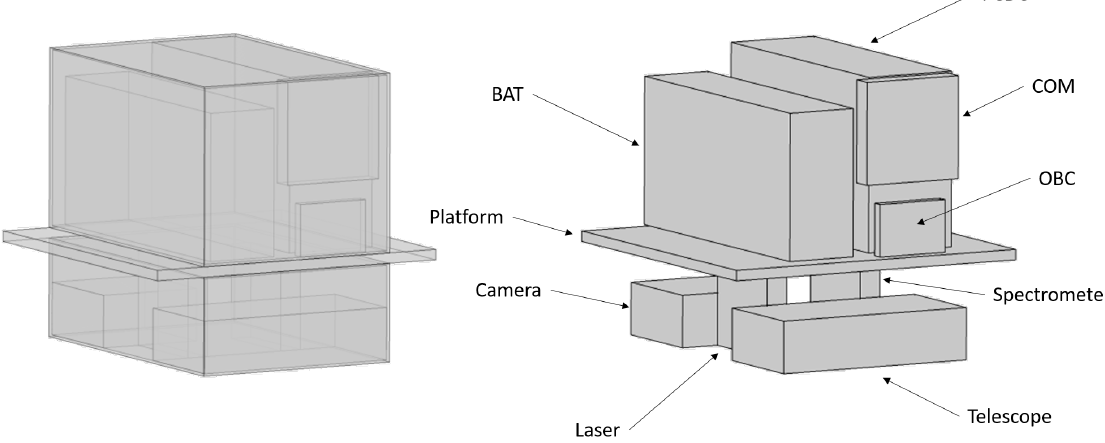
Figure 6. Detailed views of the electronics and instrument compartment of the probe, showing dummy volumes for the subsystems (housing not shown on right